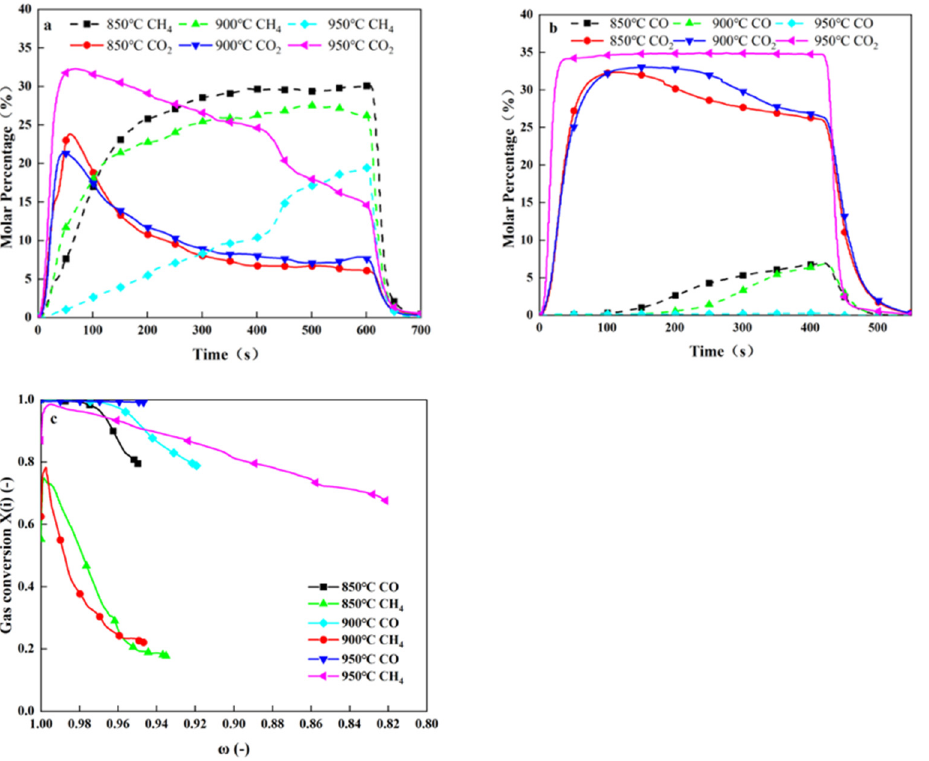
Figure 9. Effect of temperature on the reaction performance of CA70-bonded oxygen carrier: ( a ) CH 4 and CO 2 concentration curves in CH 4 experiments, ( b ) CO and CO 2 concentration curves in CO experiments, and ( c ) fuel conversion. 20% CH 4 for methane experiments, and 20% CO for carbon monoxide experiments.